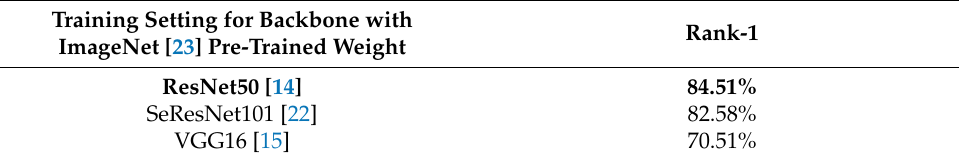
Table 1. Configuration evaluation result for backbone module.